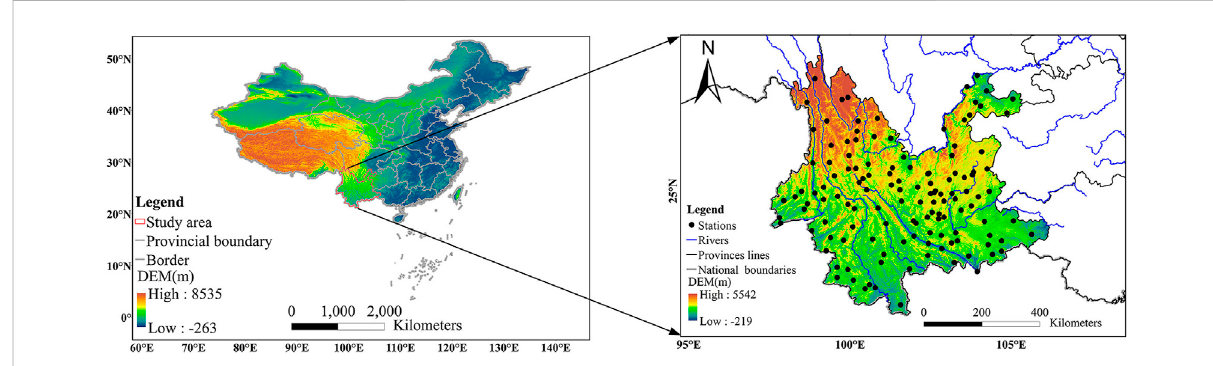
FIGURE 1 Location and digital elevation model (DEM) of the study area, and locations of the meteorological stations in Yunnan.